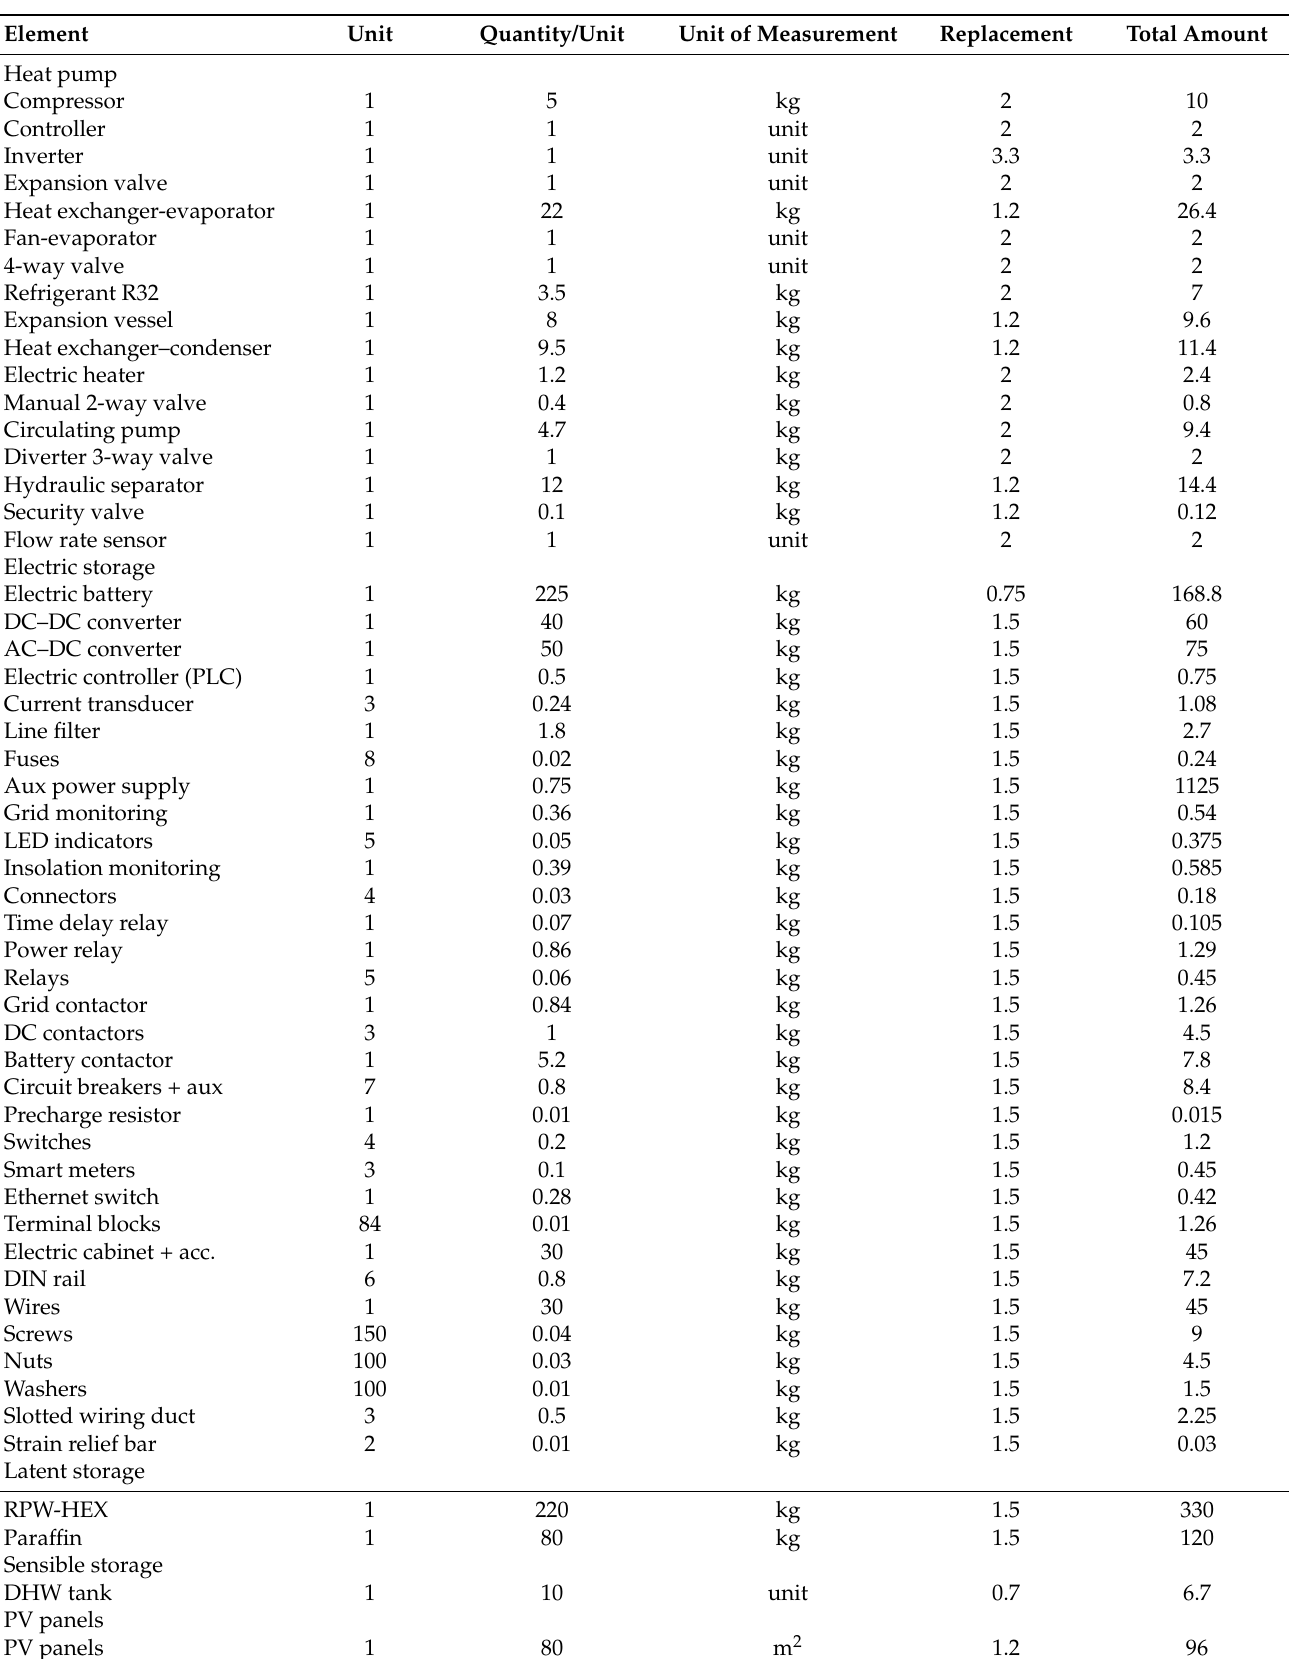
Table 4. Inventory of the innovative